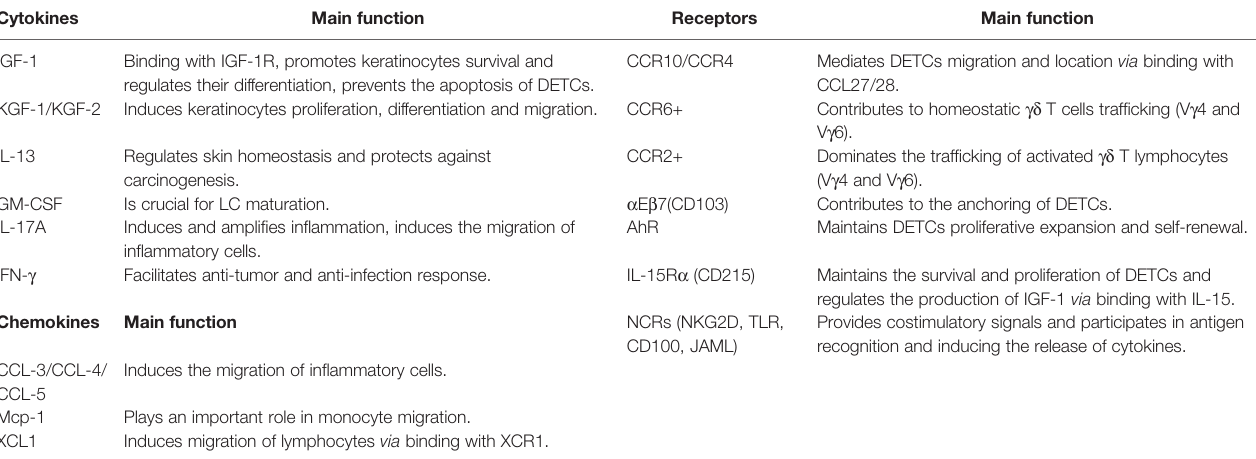
TABLE 1 | Main cytokines, chemokines, and receptors of DETCs, V g 4 and V g 6 T cells in skin homeostasis and wound healing. Cytokines Main function Receptors Main